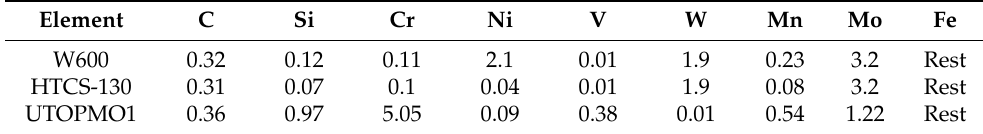
Table 1. Chemical composition (wt %) of the experimental tool steels. Element C Si Cr